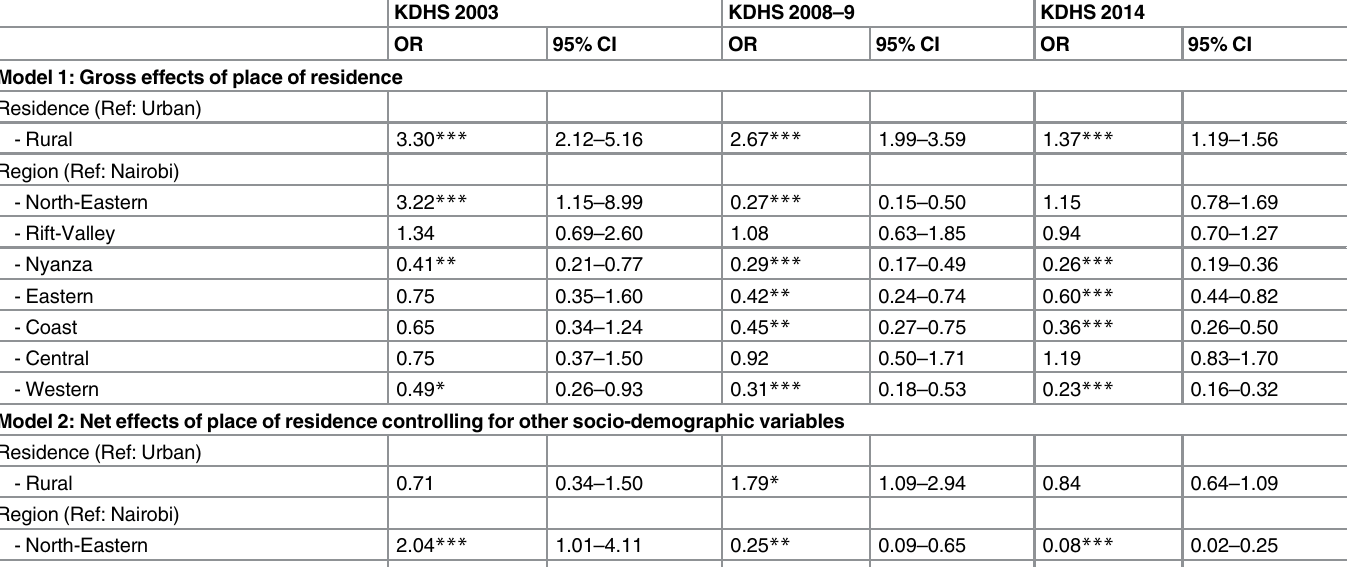
Table 5. Correlates of insecticide treated bed net